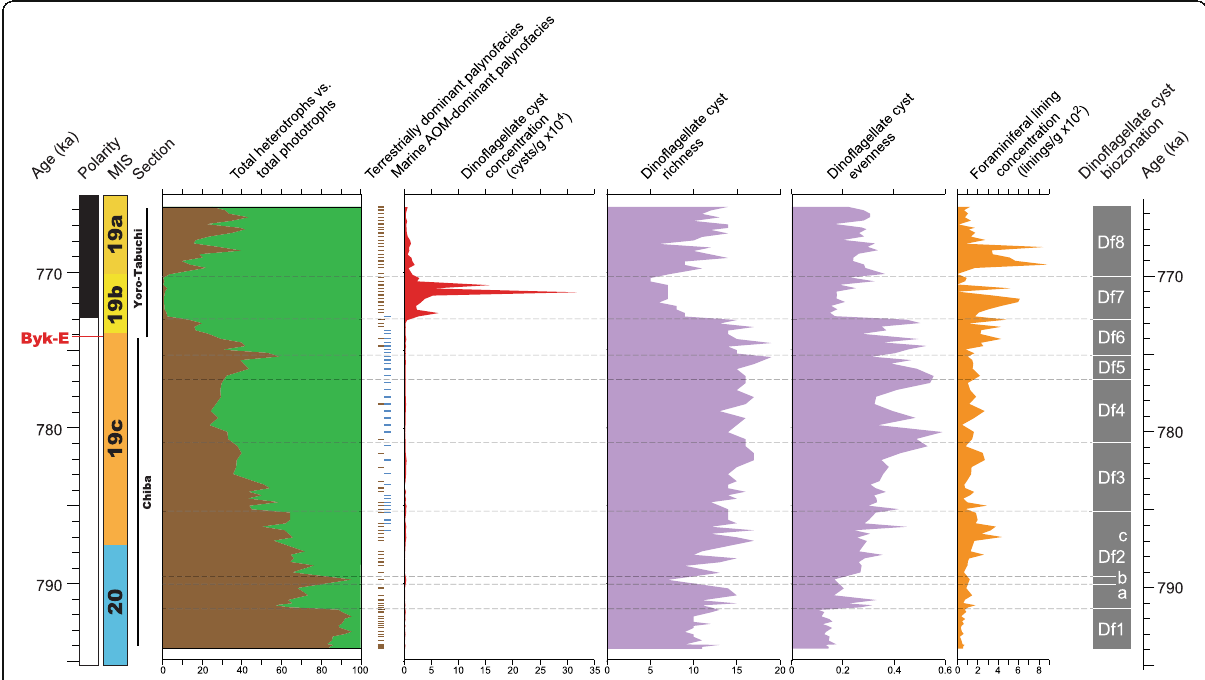
Fig. 16 Marine palynology and palynofacies of the Chiba and Yoro-Tabuchi sections plotted against the age model of Suganuma et al. (2018, in press). MIS and substage boundary positions are from Haneda et al. (2020b). The position of Byk-E tephra bed is shown. The biozonation (biozones Df1 – 8) is from the present study, with total heterotrophs (brown) versus total phototrophs expressing the overall dinoflagellate cyst assemblage compositions. Dominant palynofacies component (brown line = terrestrial represented mostly by woody and cuticular plant tissues, blue line = marine represented by amorphous organic matter [AOM]) is given for each sample based on qualitative visual estimate. In a few samples, marine and terrestrial components co-dominate. Concentrations of dinoflagellate cysts (× 10,000) and benthic microforaminiferal linings (× 100) are per gram dry weight of